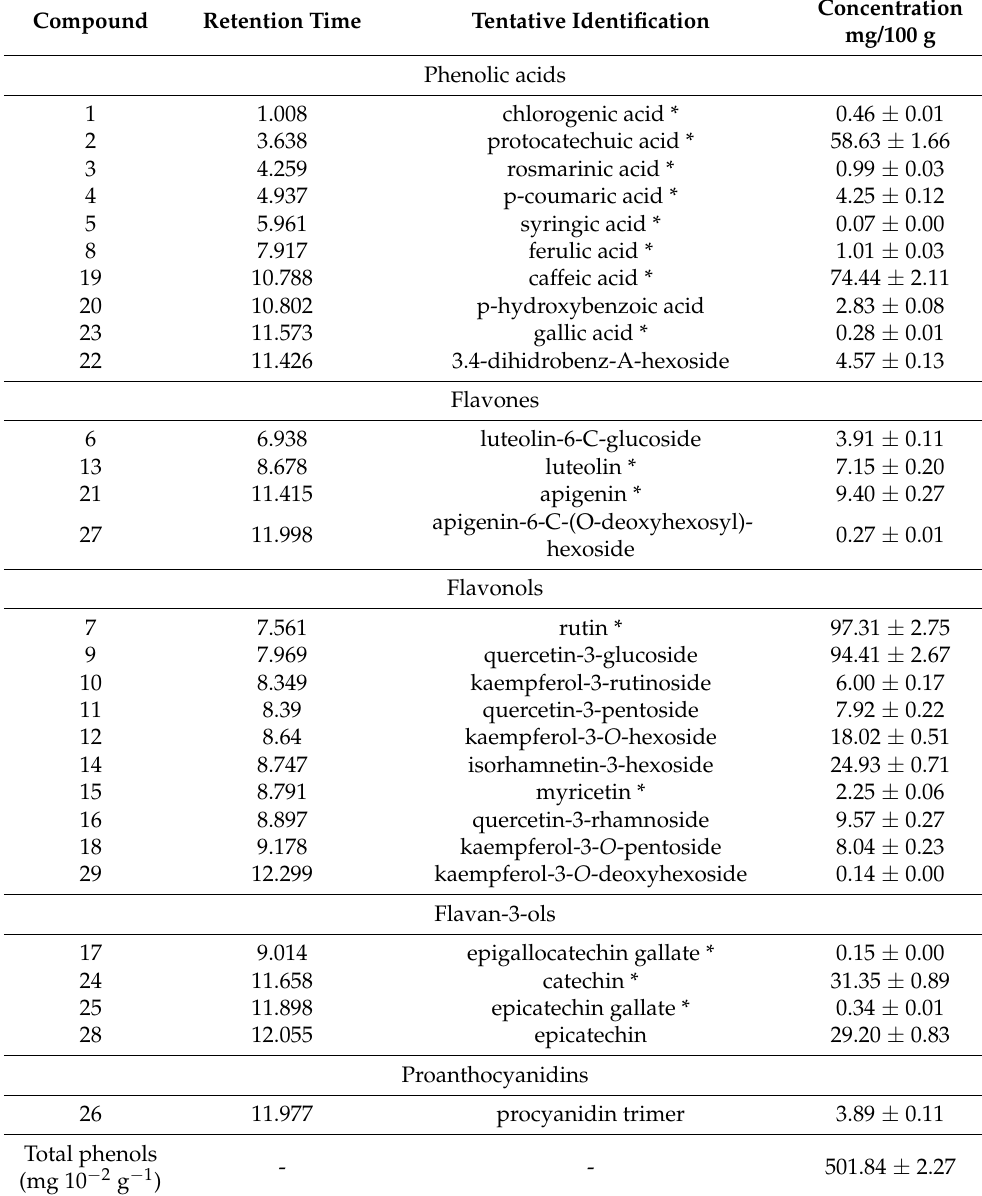
Table 3. Mass spectrometric data on laurel leaf extract obtained at optimal PLE